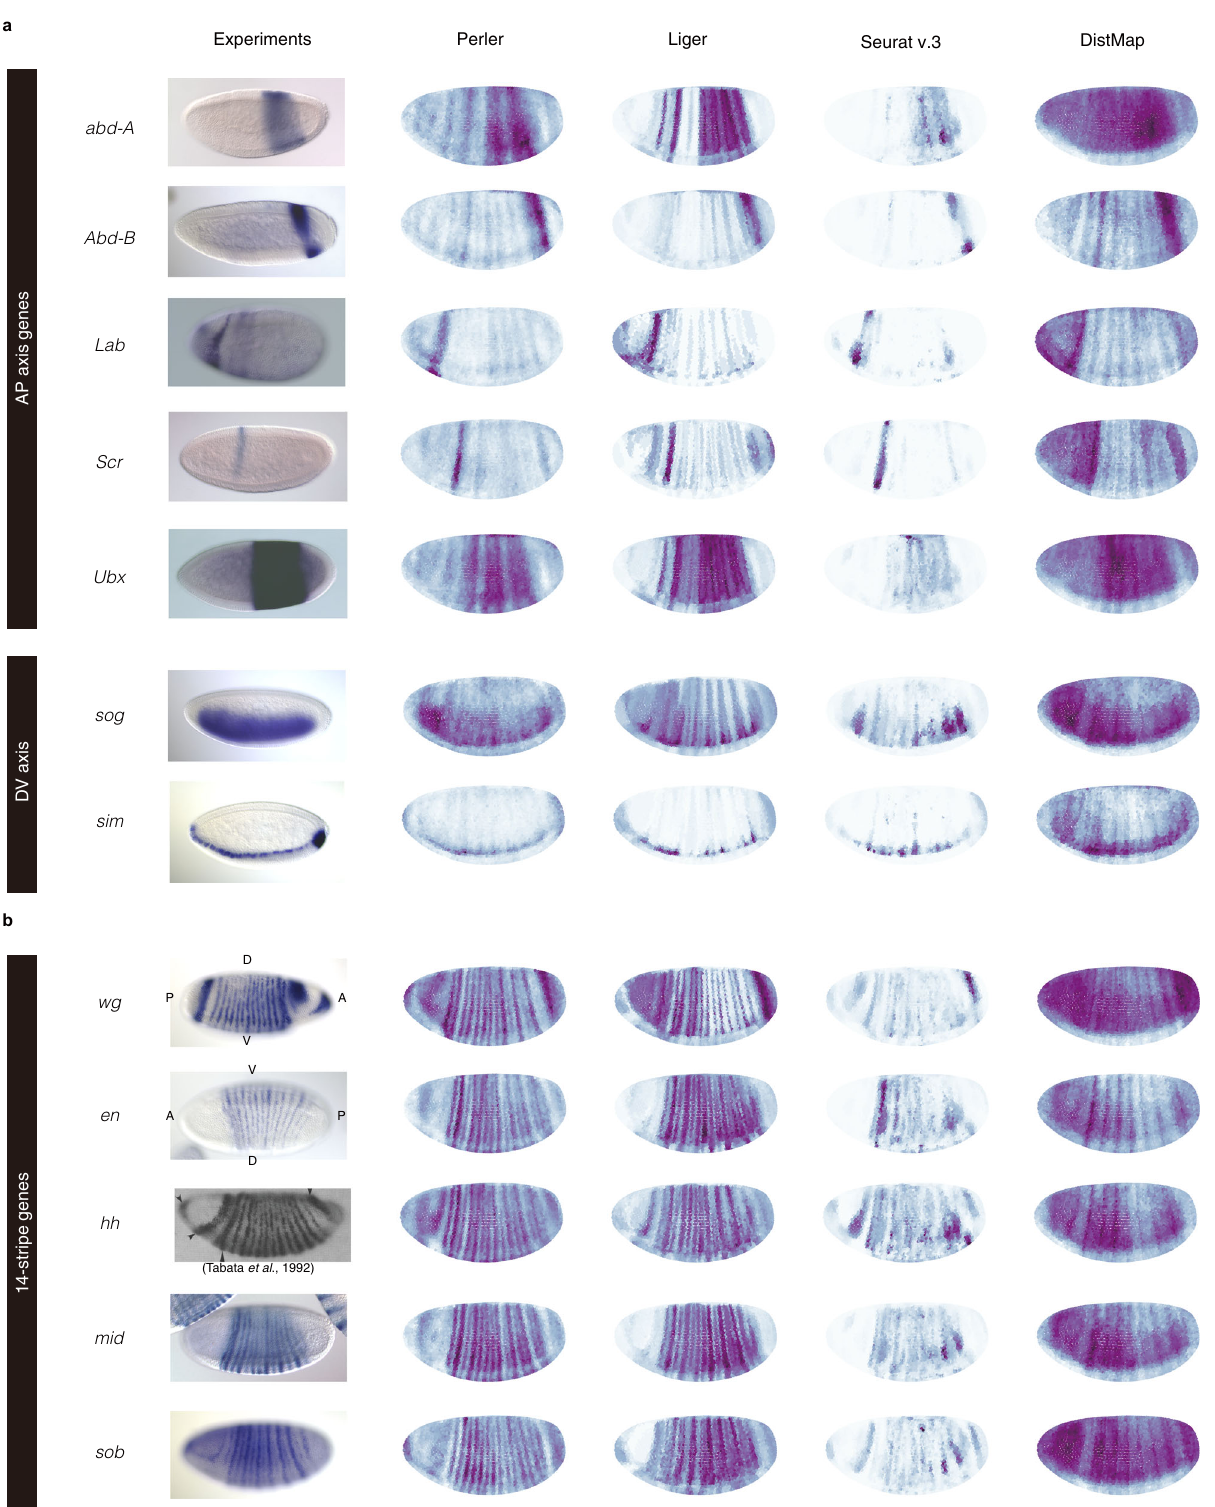
Fig. 3 Spatial prediction of non-landmark genes. Predictions of non-landmark gene expression showing a spatial expression along the A – P and D – V axes and b a 14-stripe pattern according to Perler, Liger, Seurat (v.3), and DistMap. ISH images (other than hh ) were adapted from BDGP (Berkeley